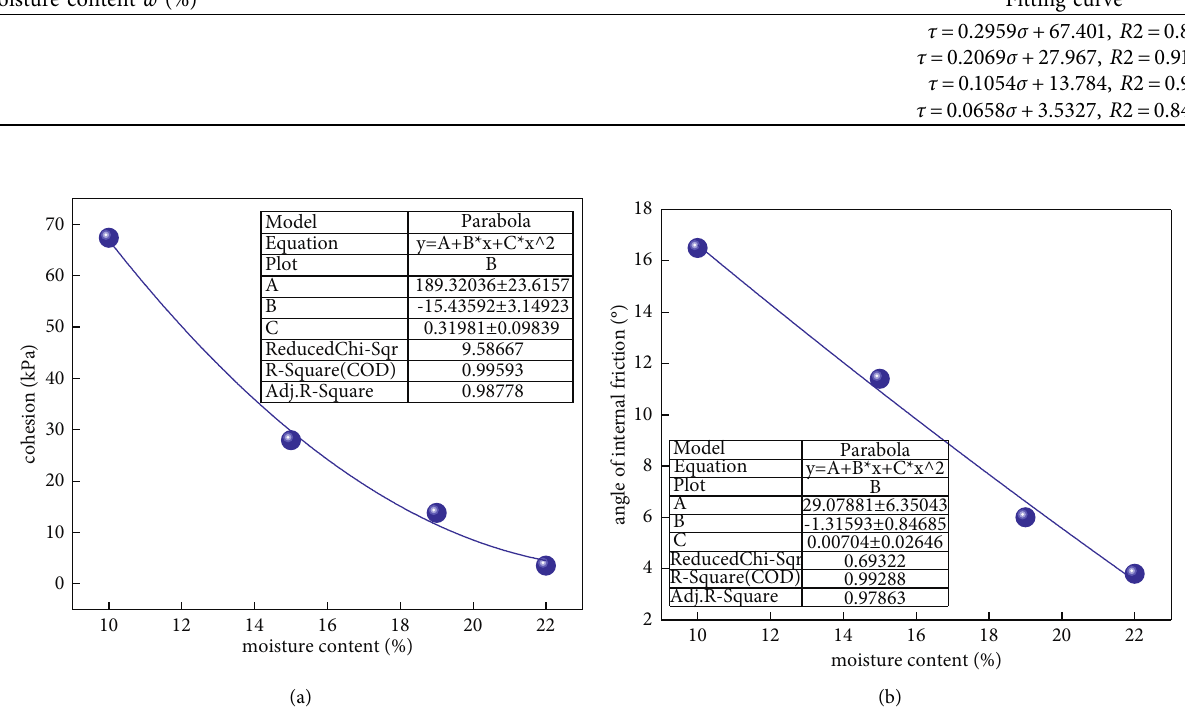
Figure 8: (a) Relationship between moisture content and cohesion of silty clay. (b) Relationship between moisture content and angle of internal